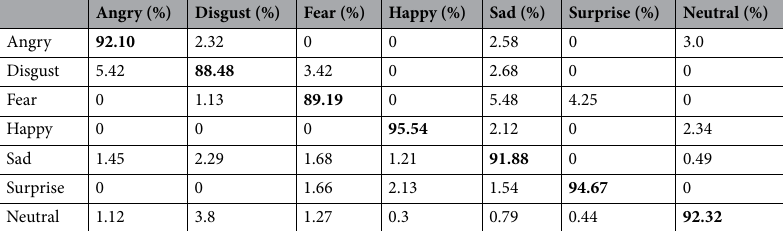
Table 4. Confusion matrix of 7 class facial emotion recognition results obtained by ConvNet with LBP on the JAFFE dataset. Significant values are in bold.